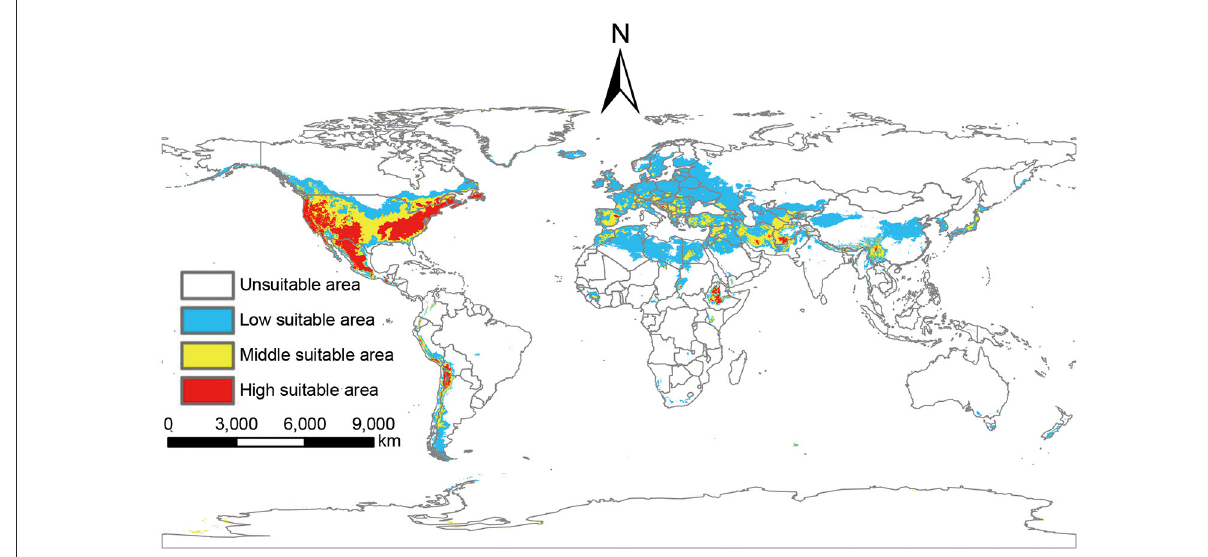
FIGURE3 Suitable areas of P. hesperomys under near-current climate conditions.